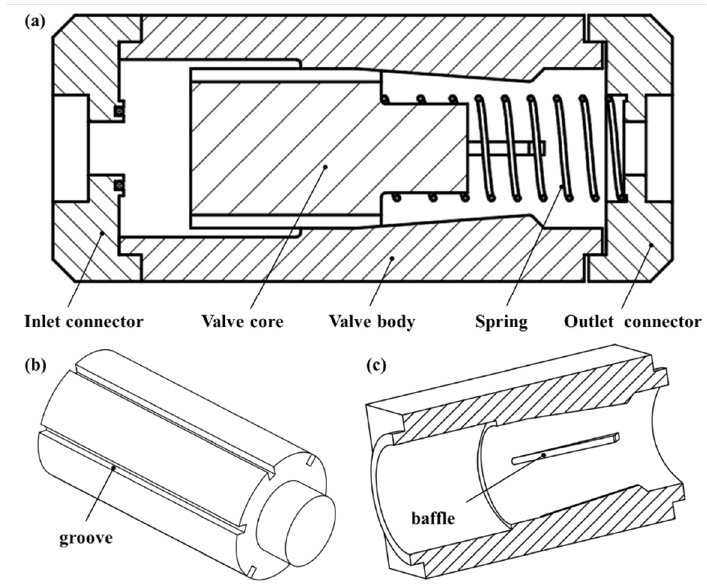
Figure 1. Structure of MPV: ( a ) MPV diagram, ( b ) valve core, ( c ) valve body. The main pressure drop inside the valve occurs when the fluid is forced to flow inside